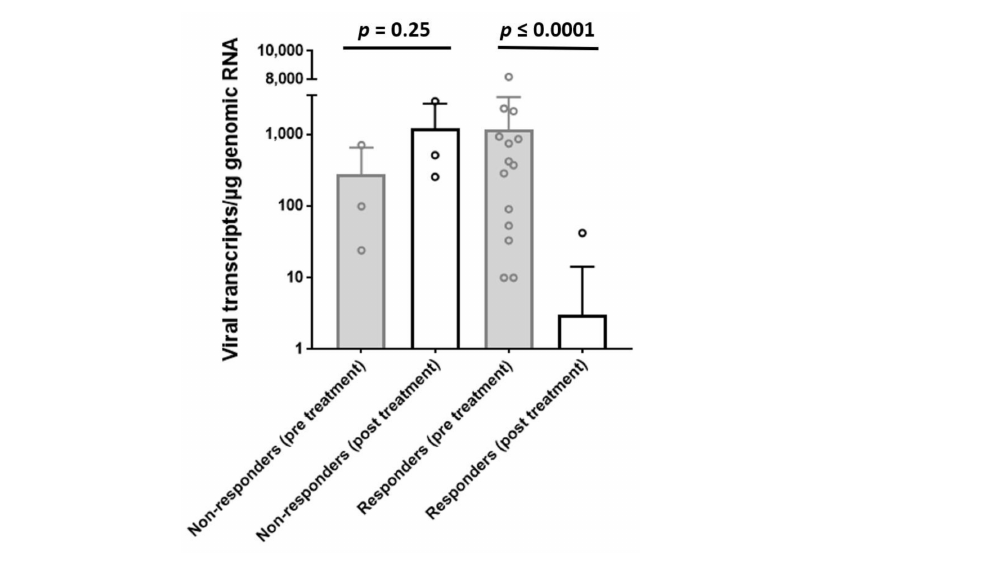
Figure 2. Number of viral RNA transcripts of non-responders and responders pre- and post-treatment. Bar height indicates the mean value ± SD expression rate of viral transcripts/ µ g RNA in non- responders’ ( n = 3) and responders’ group ( n = 14) pre (baseline) and post (follow-up) LTD-treatment. Dots indicate individual values. Whereas responders significantly reduce viral replication intermedi- ates upon treatment, non-responders show a non-significant increase of viral RNA. Viral transcripts are given as mean value and error bars represent SD.